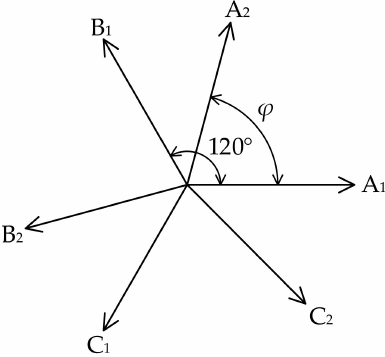
Figure 3. Phase diagram of the proposed machine.